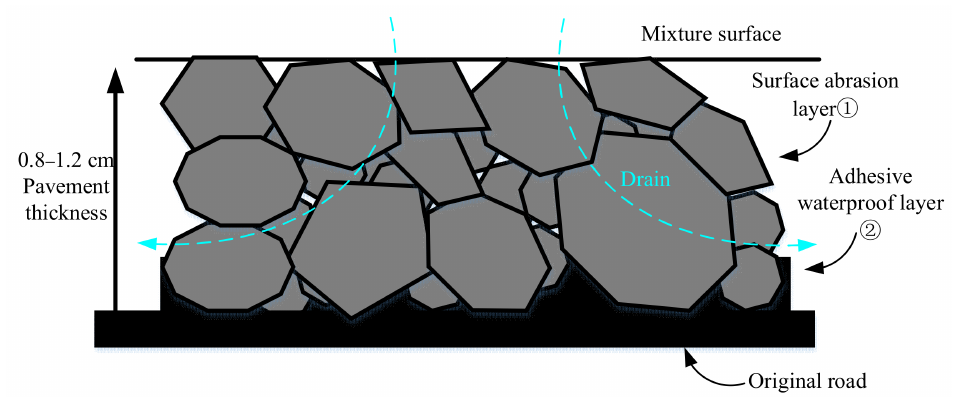
Figure 1. Structural composition and drainage of the VTAO.